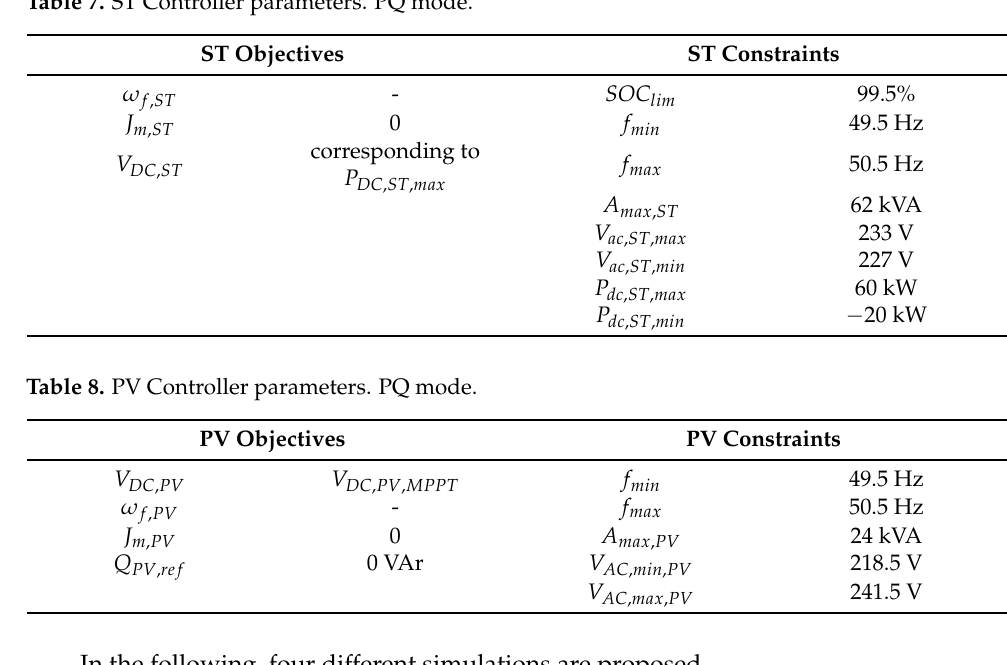
Table 7. ST Controller parameters. PQ mode.